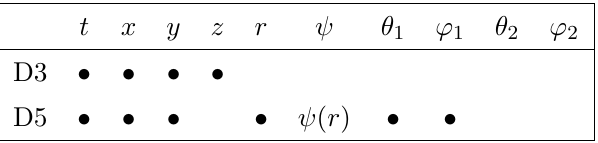
Table 1 . Choice of the D5-brane